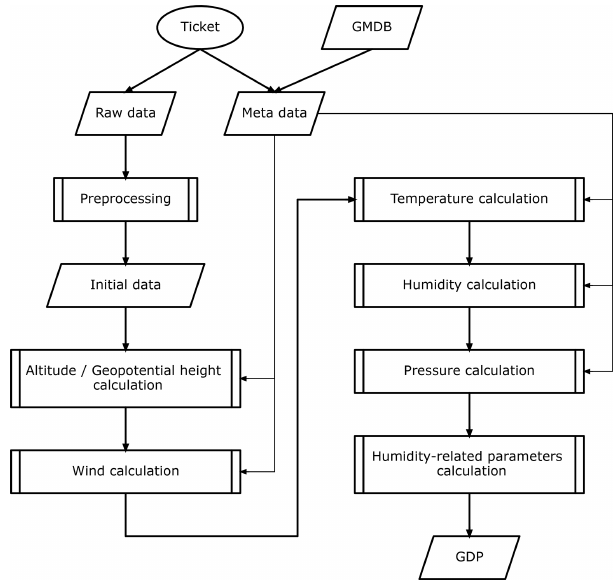
Figure 2. GRUAN data processing for iMS-100 (GMDB from GRUAN Meta-data Data Base). The circle is the process starting point. Parallelograms and rectangles with double lines on the left and right sides represent the data and sub-processes for calculation,